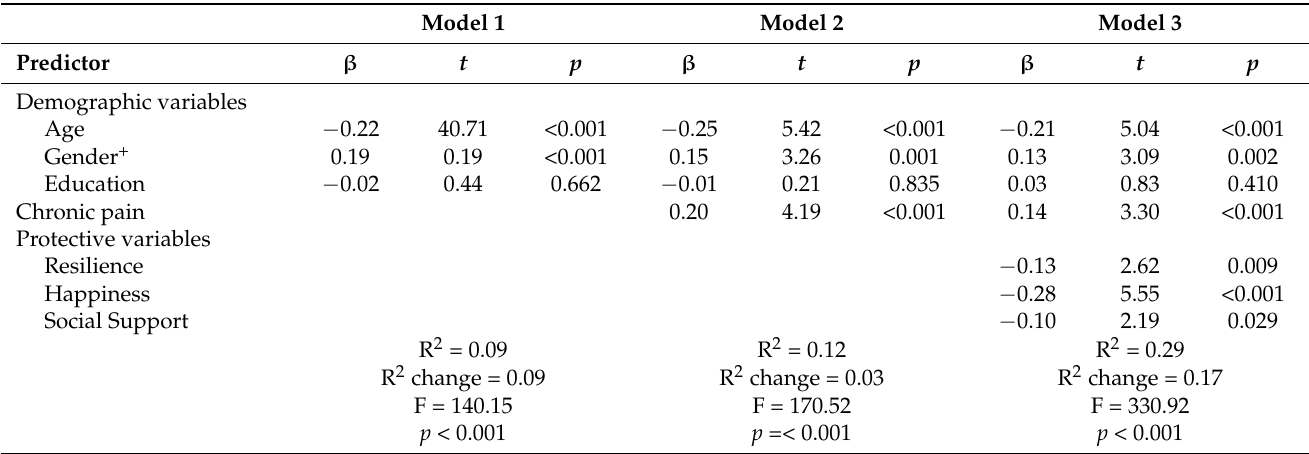
Table 6. Regression analyses predicting